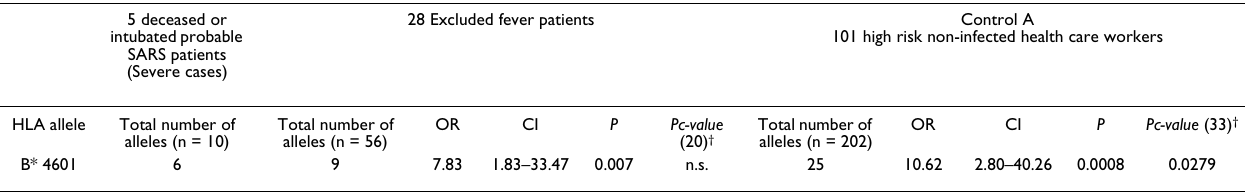
101 high risk non-infected health care